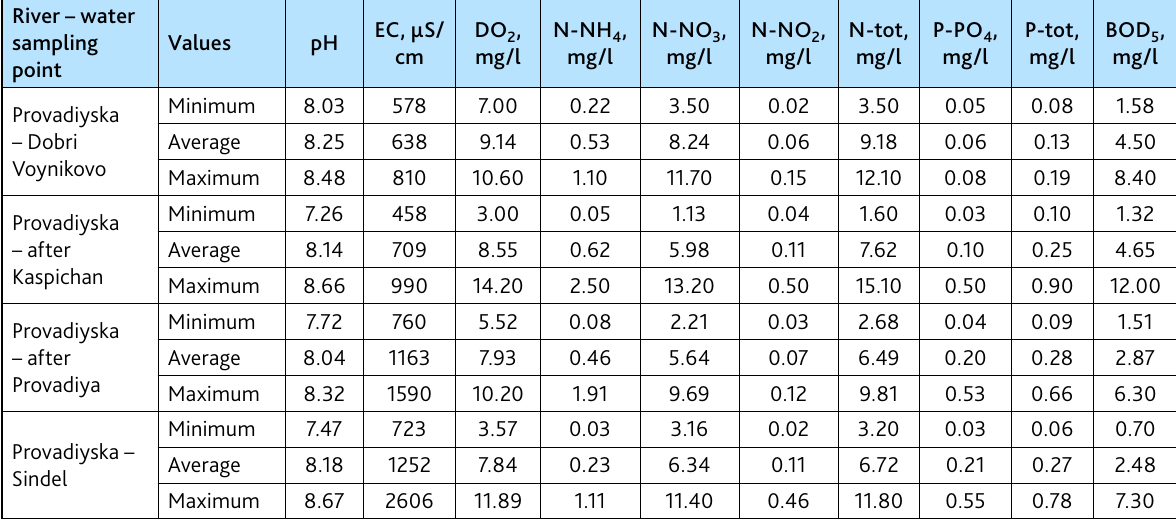
Table 2. Descriptive statistics of the values of physicochemical variables in the surface